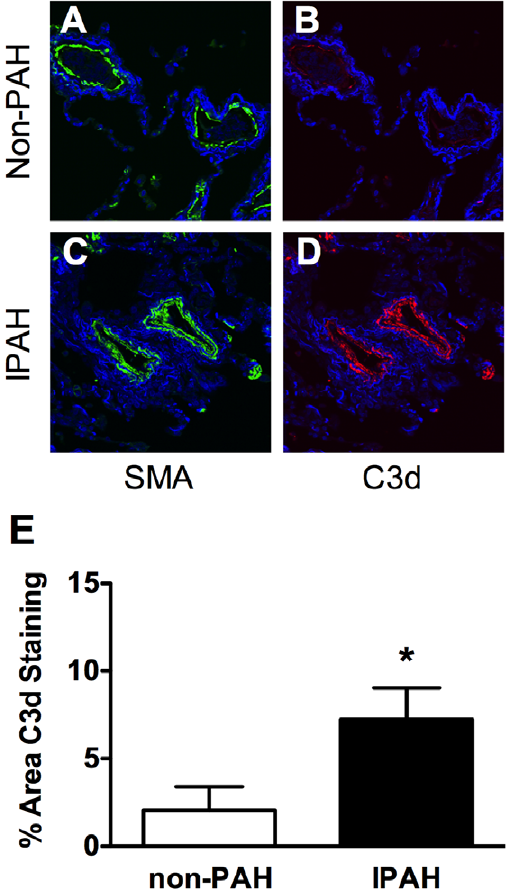
Figure 1. C3d deposition in human PAH. (A–D) Lung sections from non-PAH or IPAH patients (n=3) were stained with a -C3d and a -SMA antibody and counterstained with DAPI to detect nuclei. Images shown are representative (E) Quantification of C3d staining in non-PAH and IPAH patients. Bars represent the mean 6 SD (n=4). * P , 0.05.